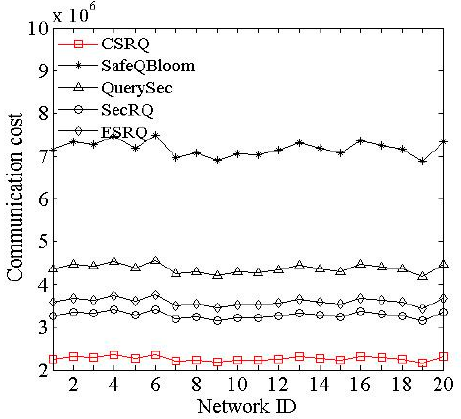
Figure 2. Impact of network ID on communication cost.